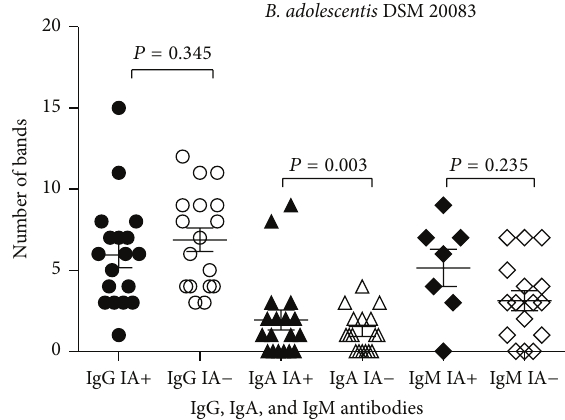
Figure 2: IgG, IgA, and IgM reactivity to B. adolescentis DSM 20086 proteins among IA-positive and IA-negative individuals.